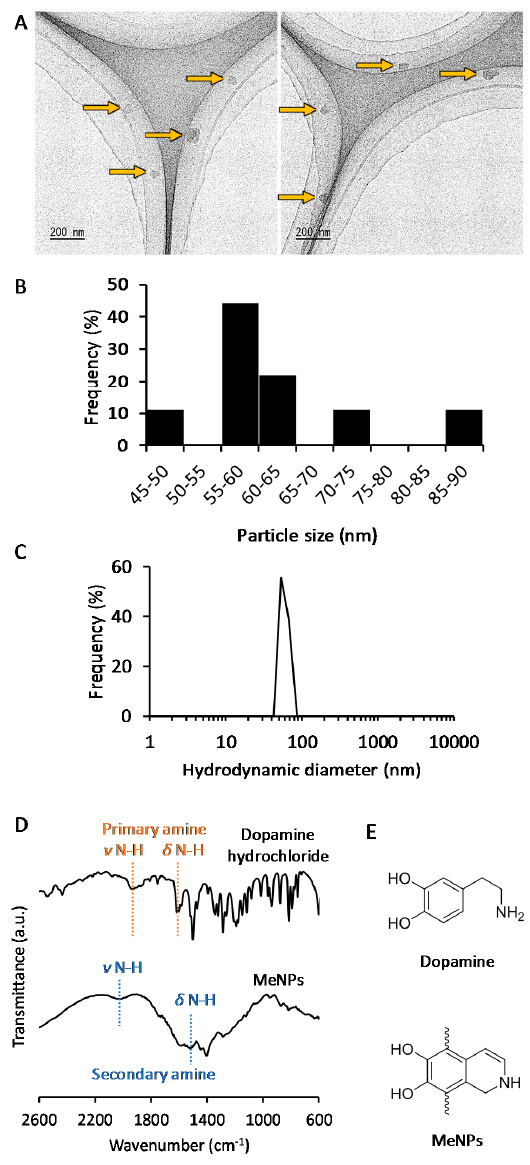
Figure 1. ( A ) Transmission electron microscopy (TEM) images of MeNPs: Yellow arrows indicate MeNPs. ( B ) Particle size distribution of MeNPs, estimated from TEM images. ( C ) Hydrodynamic diameter of MeNPs in distilled water. ( D ) Fourier Transform Infrared (FT-IR) spectra of dopamine hydrochloride and MeNPs. ( E ) Chemical structures of dopamine and MeNPs.